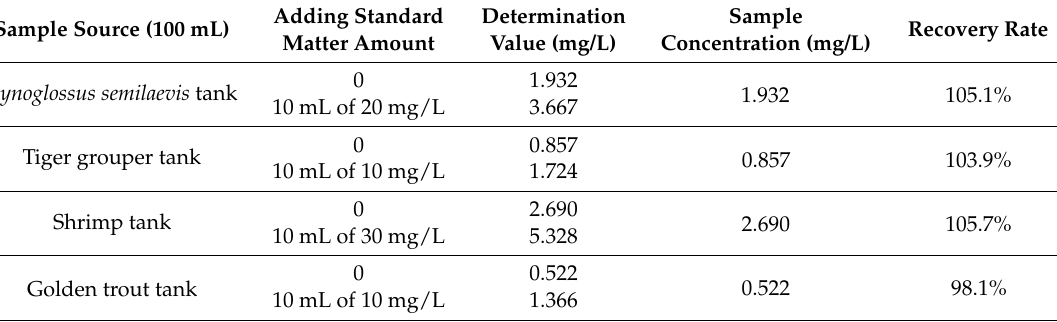
Table 3. Test results of sample recovery rate.